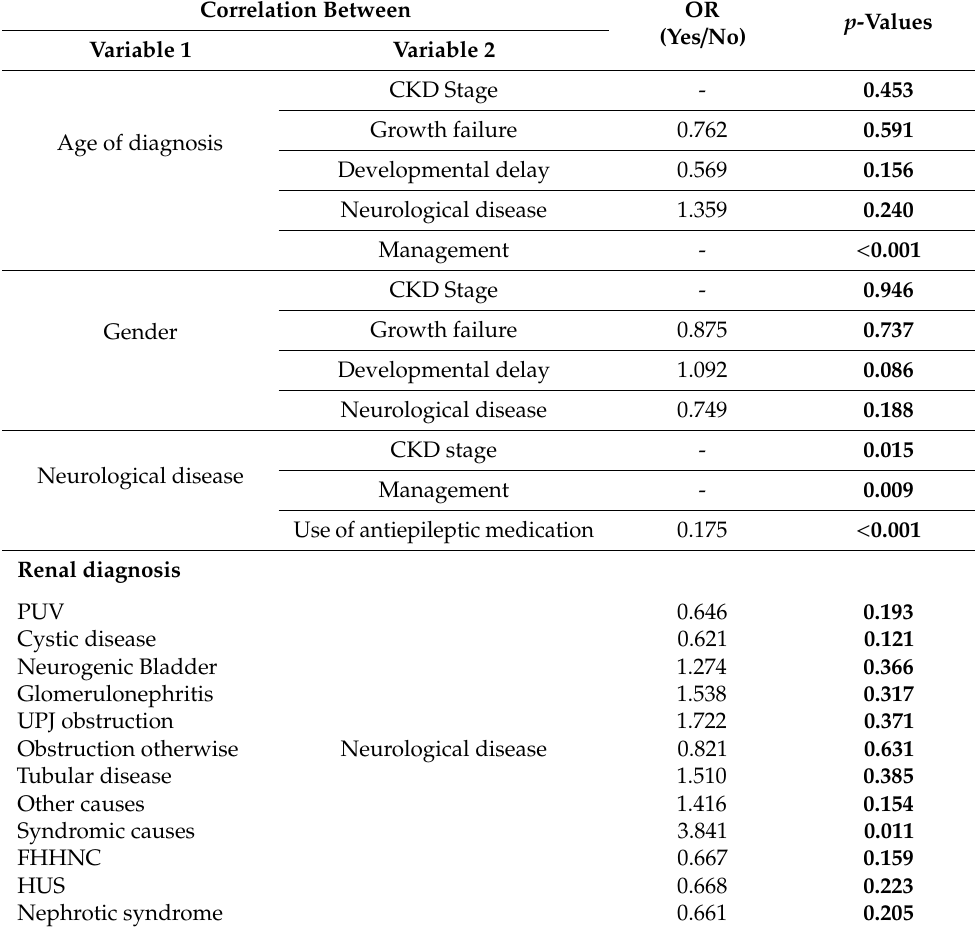
Table 2. Association between di ff erent variables by Chi-squared test ( n =